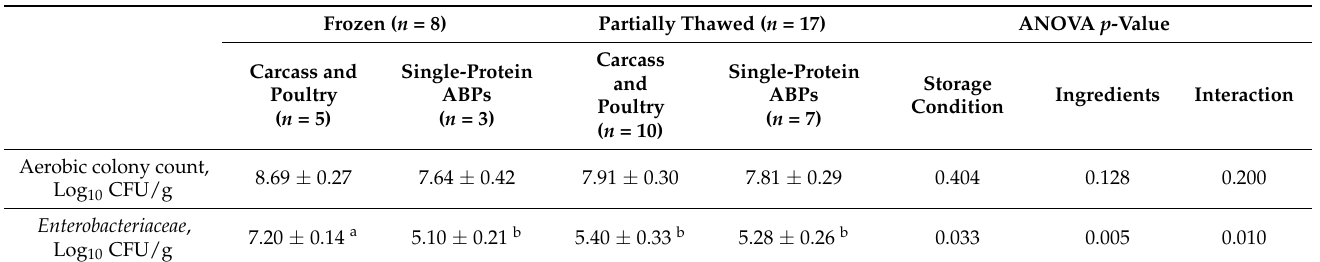
Table 5. Effects of the storage condition at arrival and specific animal source of RMBDs on aerobic colony and Enterobacteriaceae